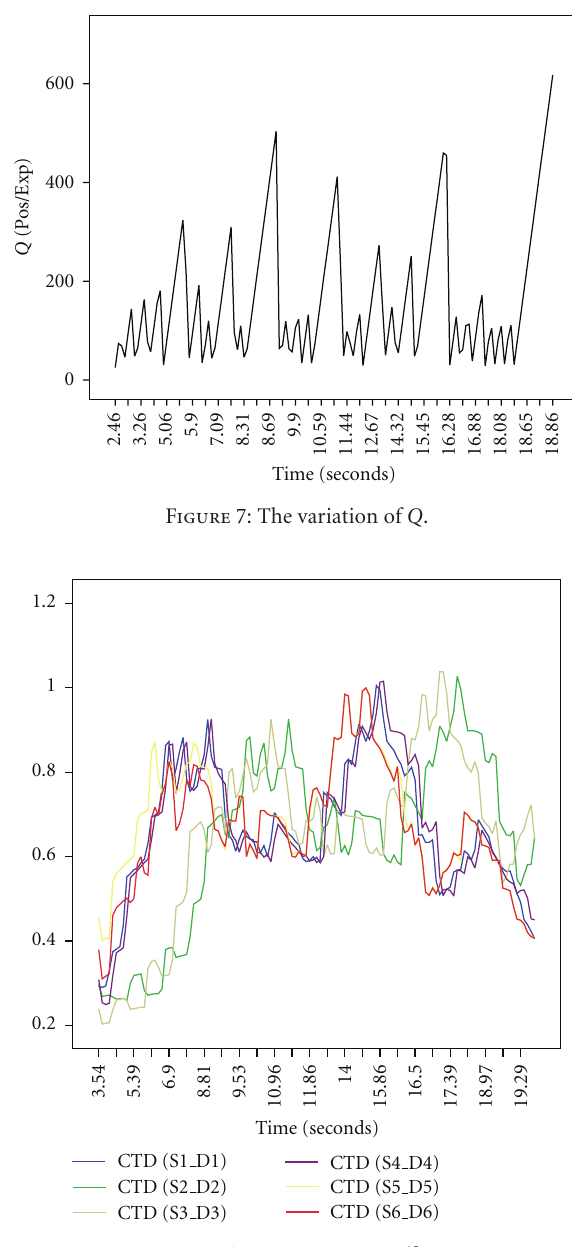
Figure 8: CTD using BL Pos / GT Exp tra ffi c